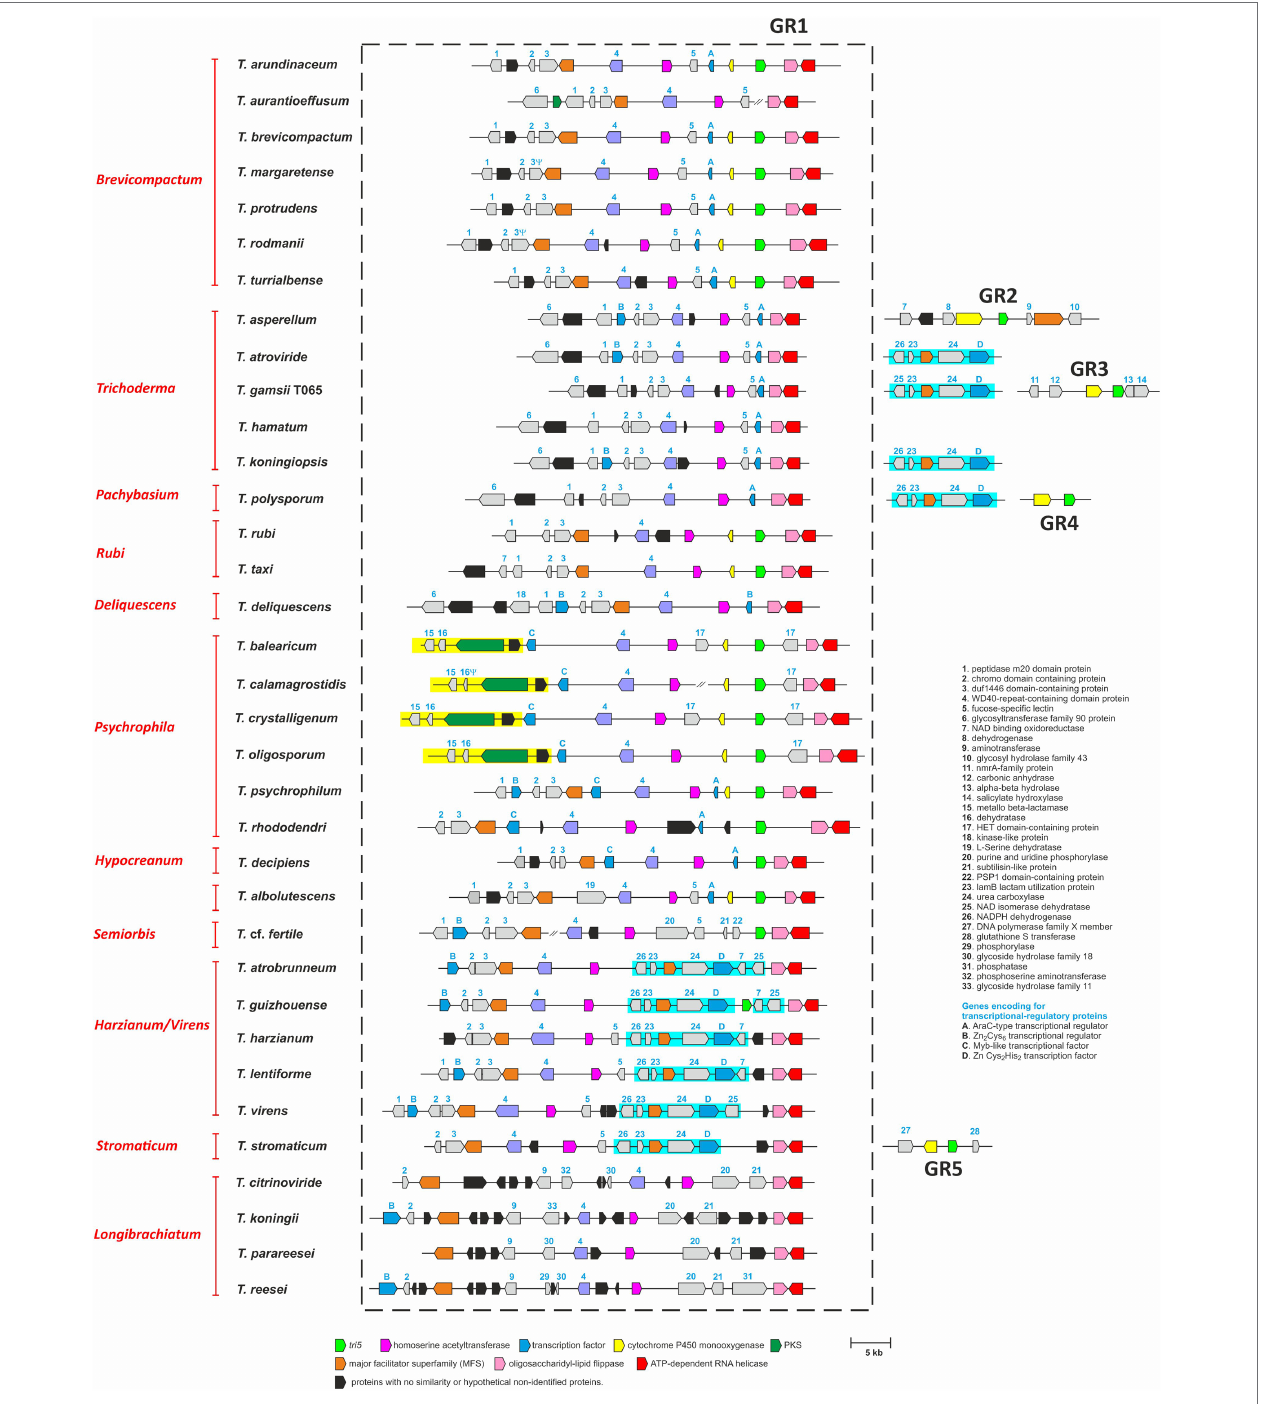
FIGURE 2 | Analysis of the gene content in homologs of the T. arundinaceum tri5 region (GR1) in 35 Trichoderma species. tri5 was absent in GR1 homologs from 17 species and occurred at genomic locations other than GR1 in four species: GR2 in T. asperellum , GR3 in T. gamsii T065, GR4 in T. polysporum , and GR5 in T. stromaticum . Genes are represented by arrows that point in the direction of transcription. Numbers or letters above genes correspond to the numbers in the list of 37 proteins on the right side of the figure; the list indicates the predicted gene/protein functions based on sequence homology. Genes that are potentially involved in secondary metabolite biosynthesis and/or included in subsequent analyses are depicted as colored arrows. tri5 is depicted as a bright green arrow; genes that do not exhibit homology to genes of known function are depicted as black arrows, and all other genes are depicted as gray arrows. Groups of arrows that are within a yellow or blue rectangle indicate multigene segments of DNA inserted into GR1. Names in red type on the left side of the figure are lineages of Trichoderma (Kubicek et al.,